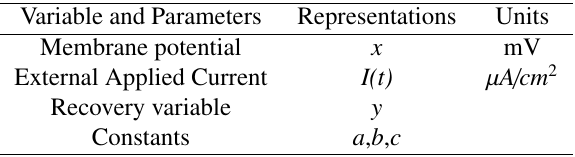
Table 1. Description of variables and